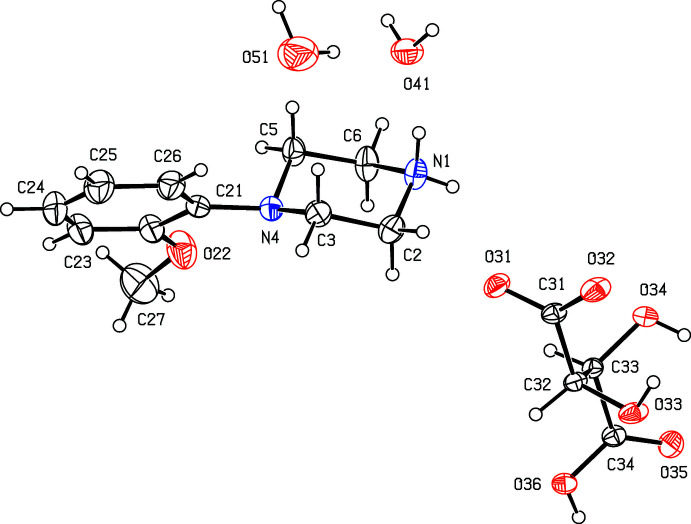
The independent components of compound (XV) showing the atom-labelling scheme. Displacement ellipsoids are drawn at the 30% probability level.